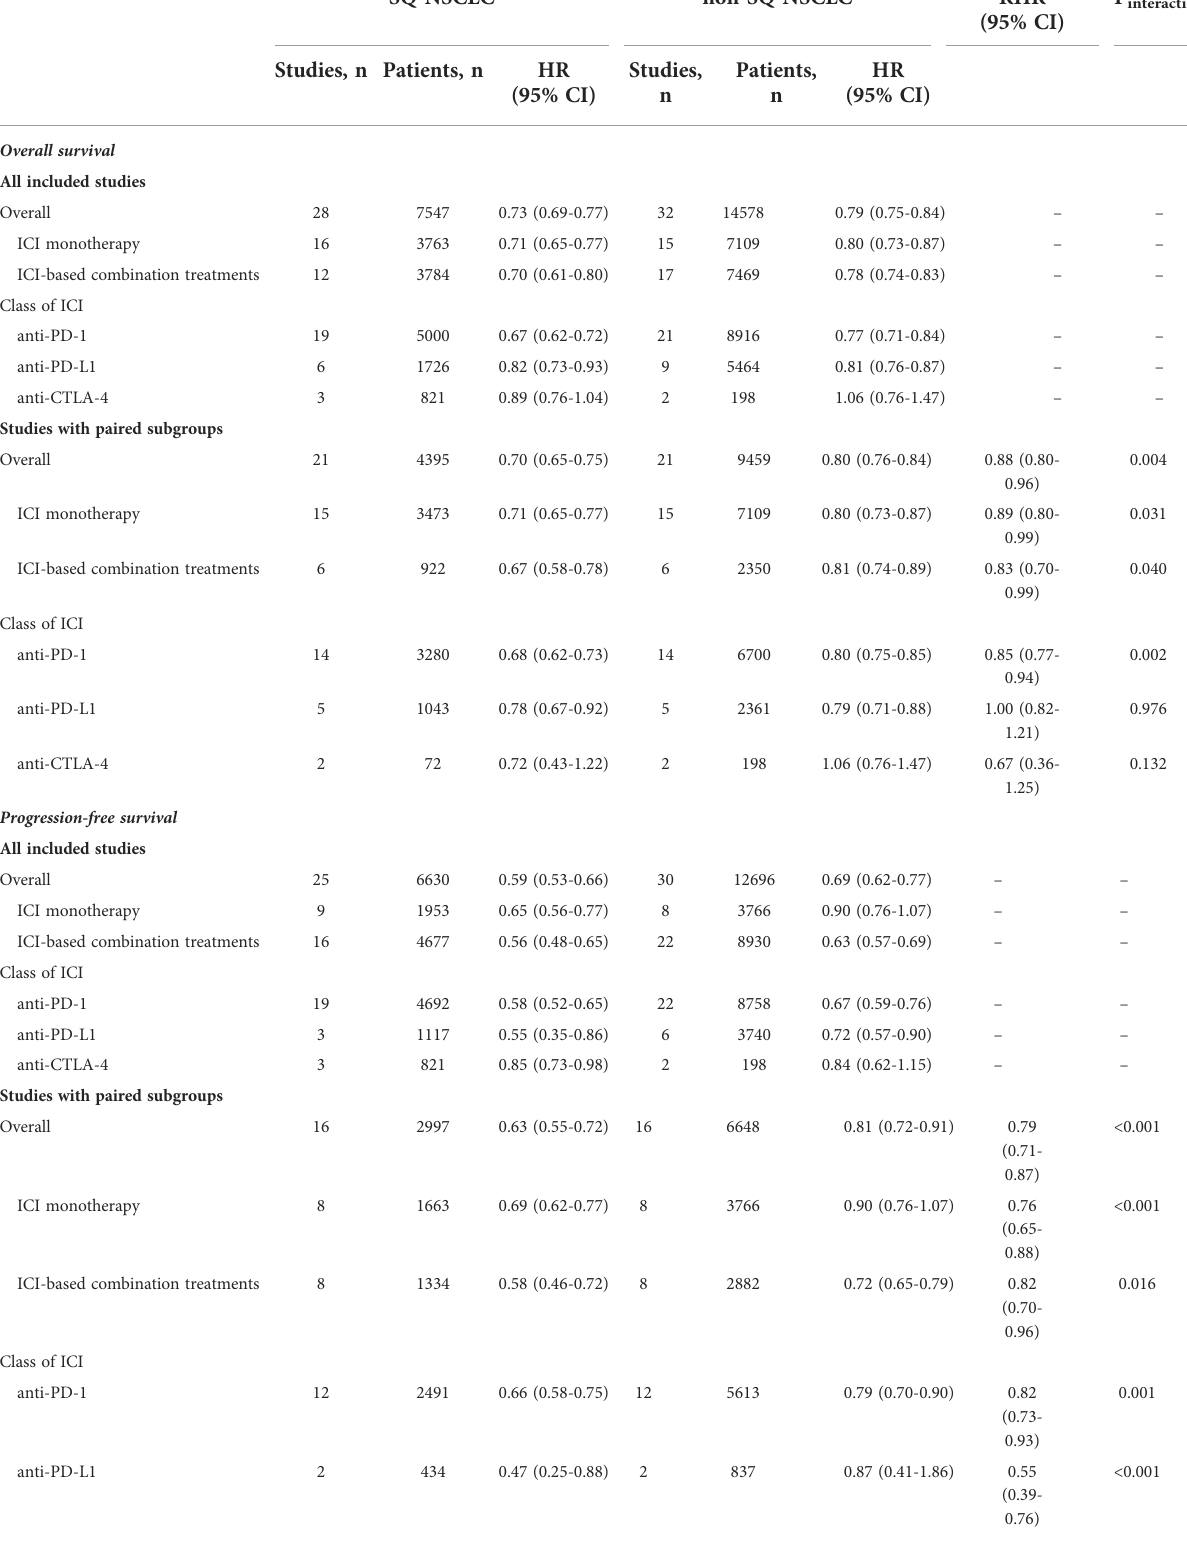
TABLE 2 Pooled HRs and pooled ratios of HRs for OS and PFS by